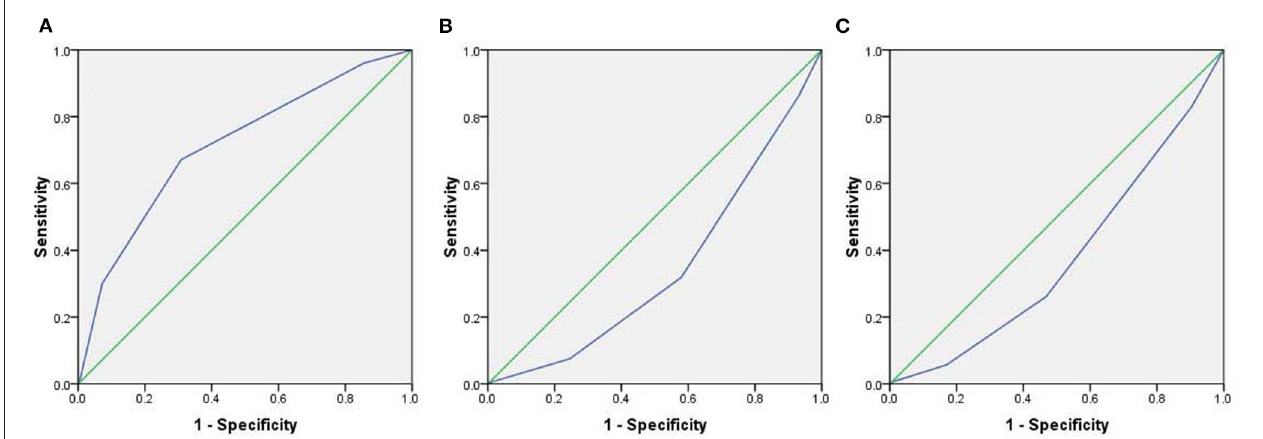
FIGURE 1 | The Roc curve demonstrates the level of severity of post-vaccinal side effects and type of the vaccines. (A) ChAdOx1 vaccine, (B) A single dose of BNT162b2 vaccine, (C) Two doses of BNT162b2 vaccine.